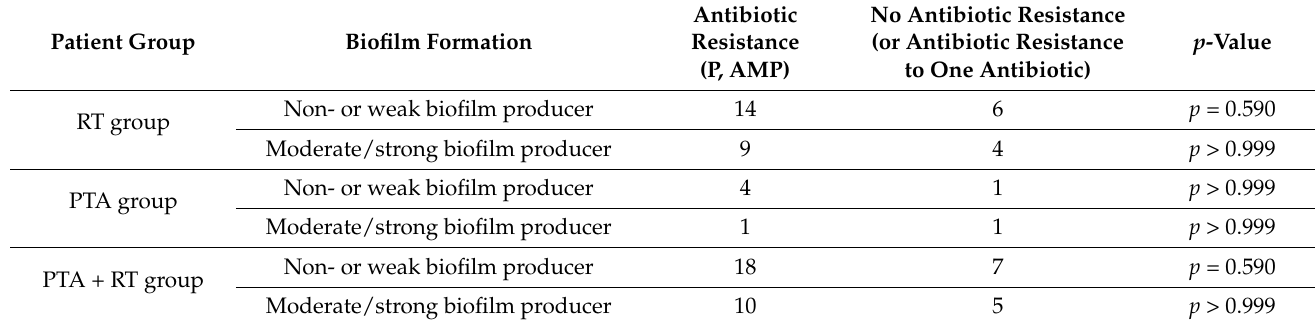
Table 4. Antibiotic-susceptibility and biofilm-production-ability patterns of S. aureus strains by patient